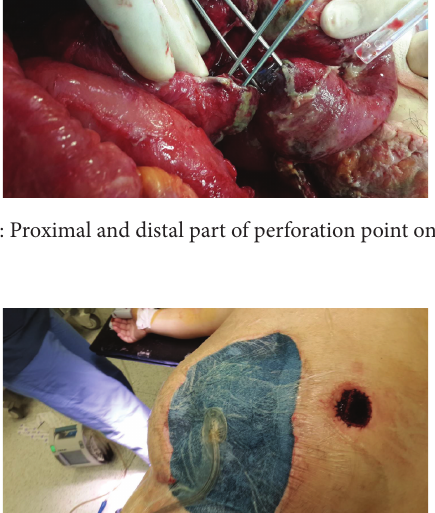
Figure 4: After midline incision was added, excessive amount of enteric influents, edematous and fragile intra-abdominal visceral tissue, and excessive adhesions are seen.